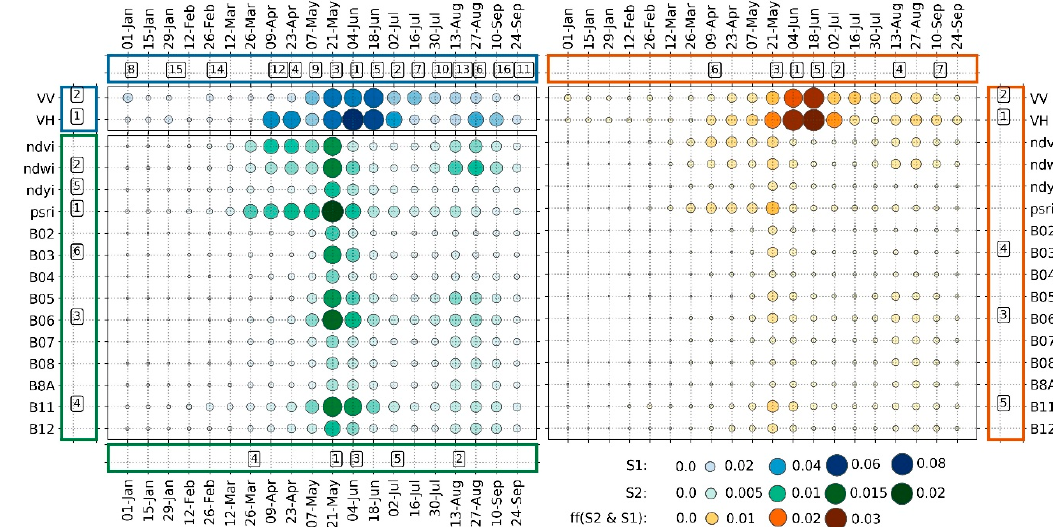
Figure 12. Feature importance derived from RF models built using only optical, only SAR, and optical-SAR features. Circles illustrate the RF importance scores, while border axes illustrate the number of sequences at which variable-wise and time-wise gFFS have been picked.